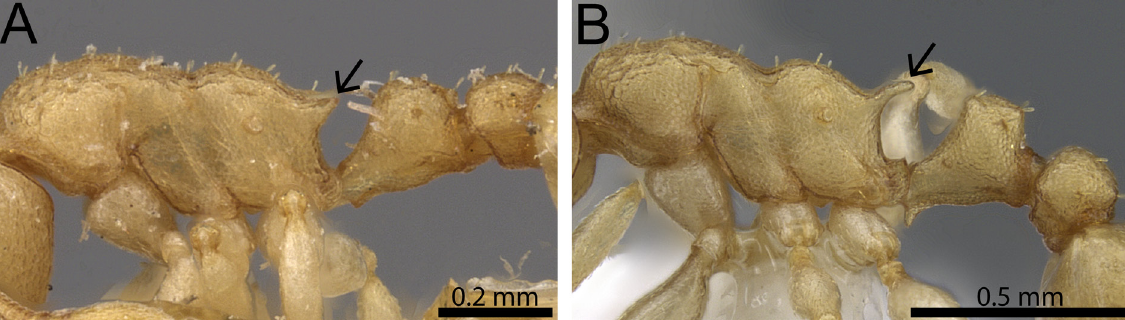
Fig. 13. Mesosoma and waist segments in profile. A . Nesomyrmex innocens (Forel, 1913) (CASENT0908995). B . N. stramineus (Arnold, 1948)